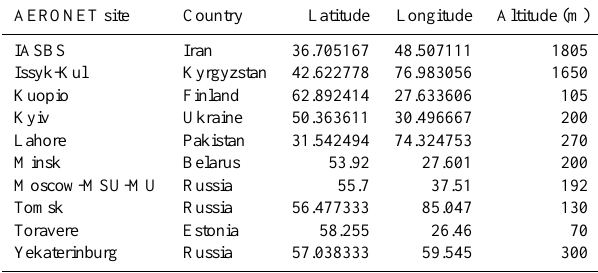
Table 1. AERONET sites selected for